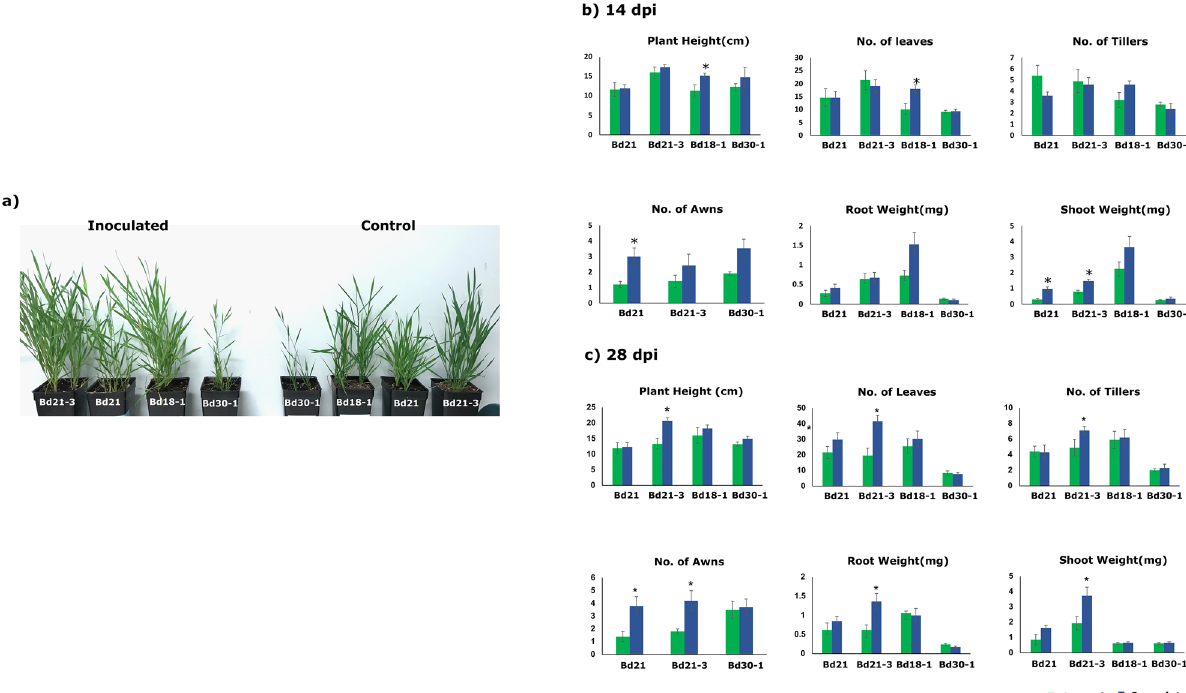
Figure 1. ( a ) Brachypodium accession lines displaying growth response at 28 days post-inoculation (dpi). The left panel of ( a ) shows accession lines (Bd21-3, Bd21, Bd18-1 and Bd30-1) inoculated with Bacillus velezensis strain B26. The right panel shows control accession lines ( b ) Growth response parameters (Plant height, No. of leaves, No. of tillers, No, of awns, Root weight and shoot weight) of wild type B.distachyon genotypes in response to B26 inoculation at 14 days post-inoculation (dpi) ( c ) at 28 dpi. Bars represent the mean of five biological replicates. t-test was used to determine statistical differences between inoculated and non-inoculated plants. * indicates significance according to Independent Student t-test ( p < 0.05). Note: Bd18-1 did not flower at 14 and 28dpi. Average Cq $ values Gene copies/g of Accession dpi